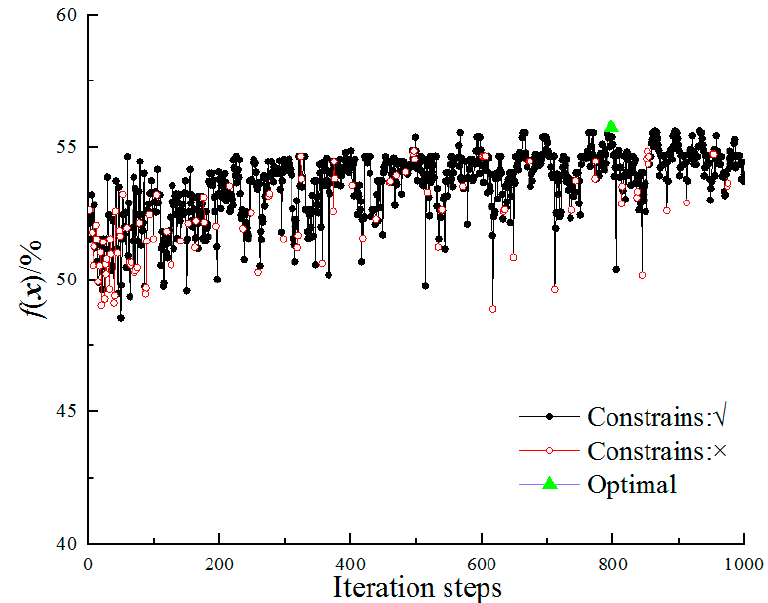
Figure 16. The iteration process of optimization.